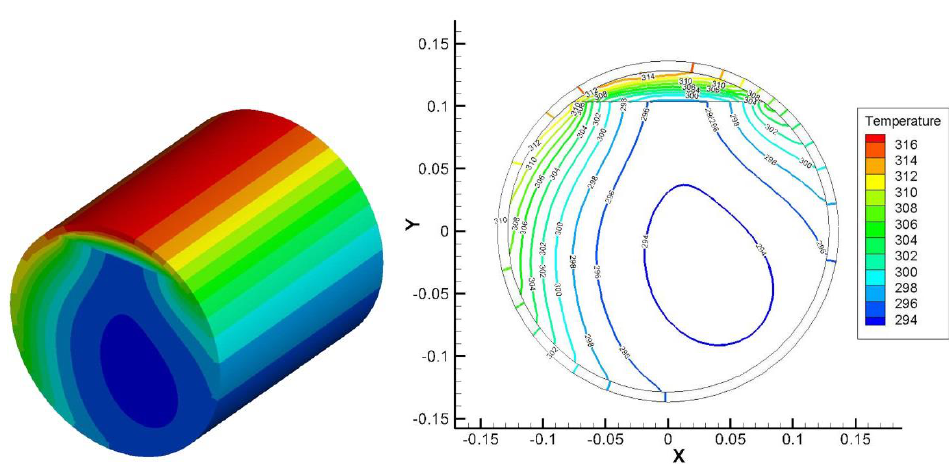
Figure 6. Temperature cloudy map and isopleth at 45° (unit: K).